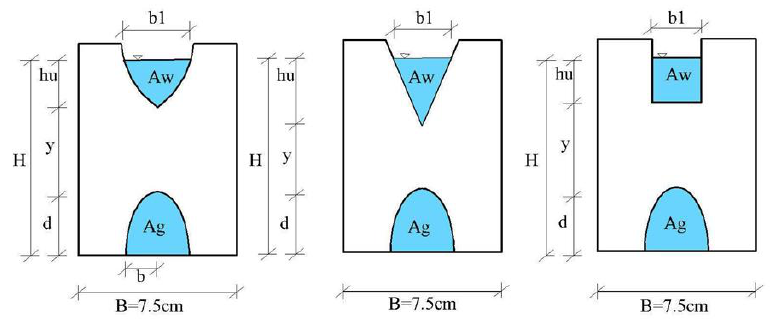
Figure 1. The details of weir-gate structure Table 1. The details of weir-gate structure